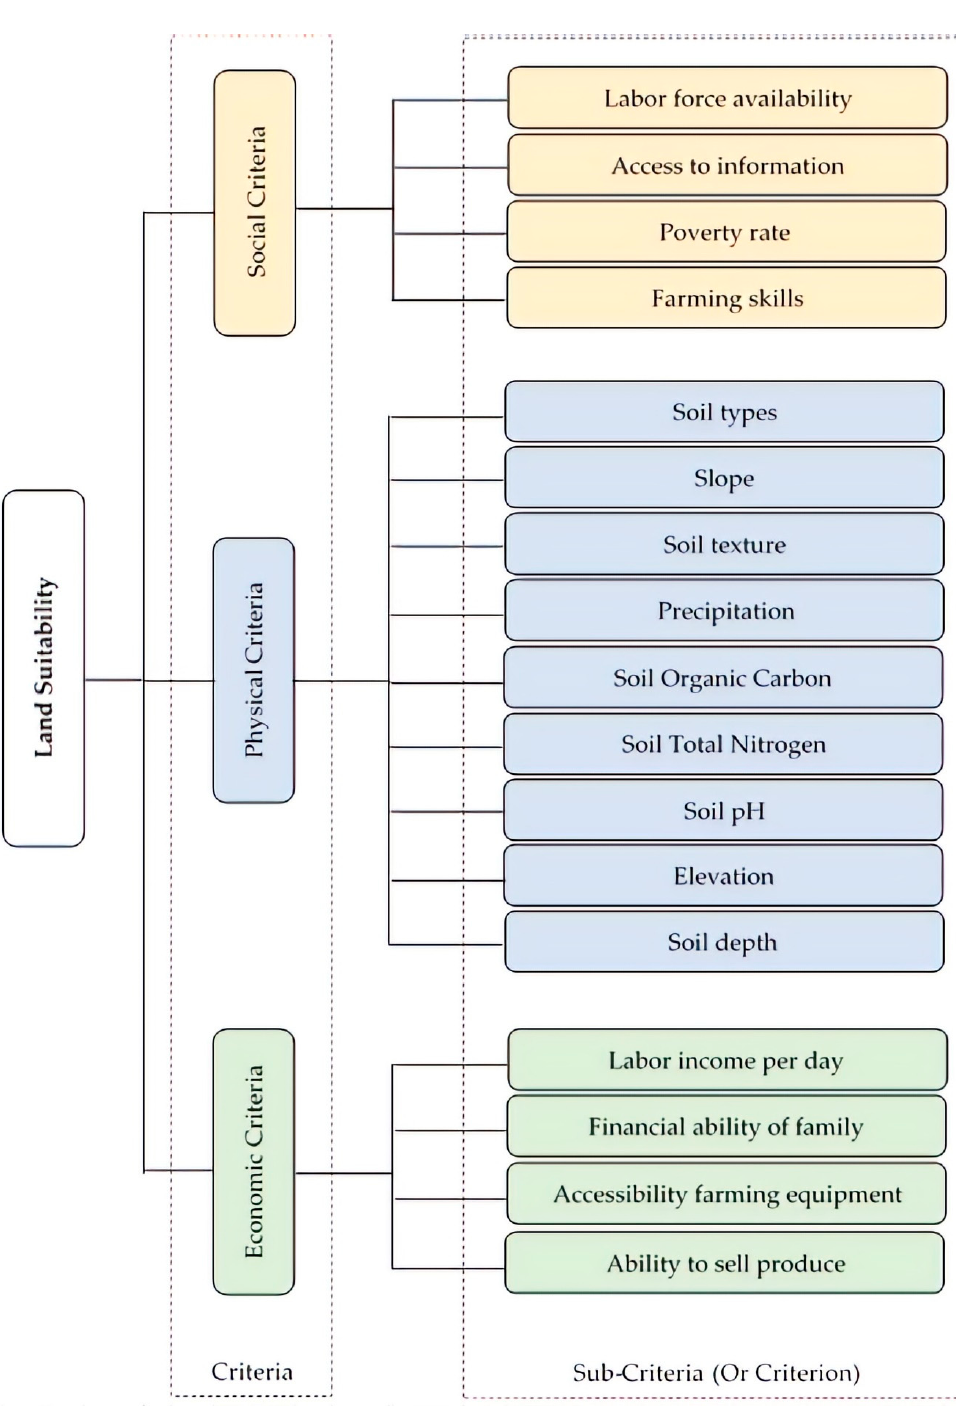
Figure 2. Hierarchical Structure of the Land Suitability Evaluation.